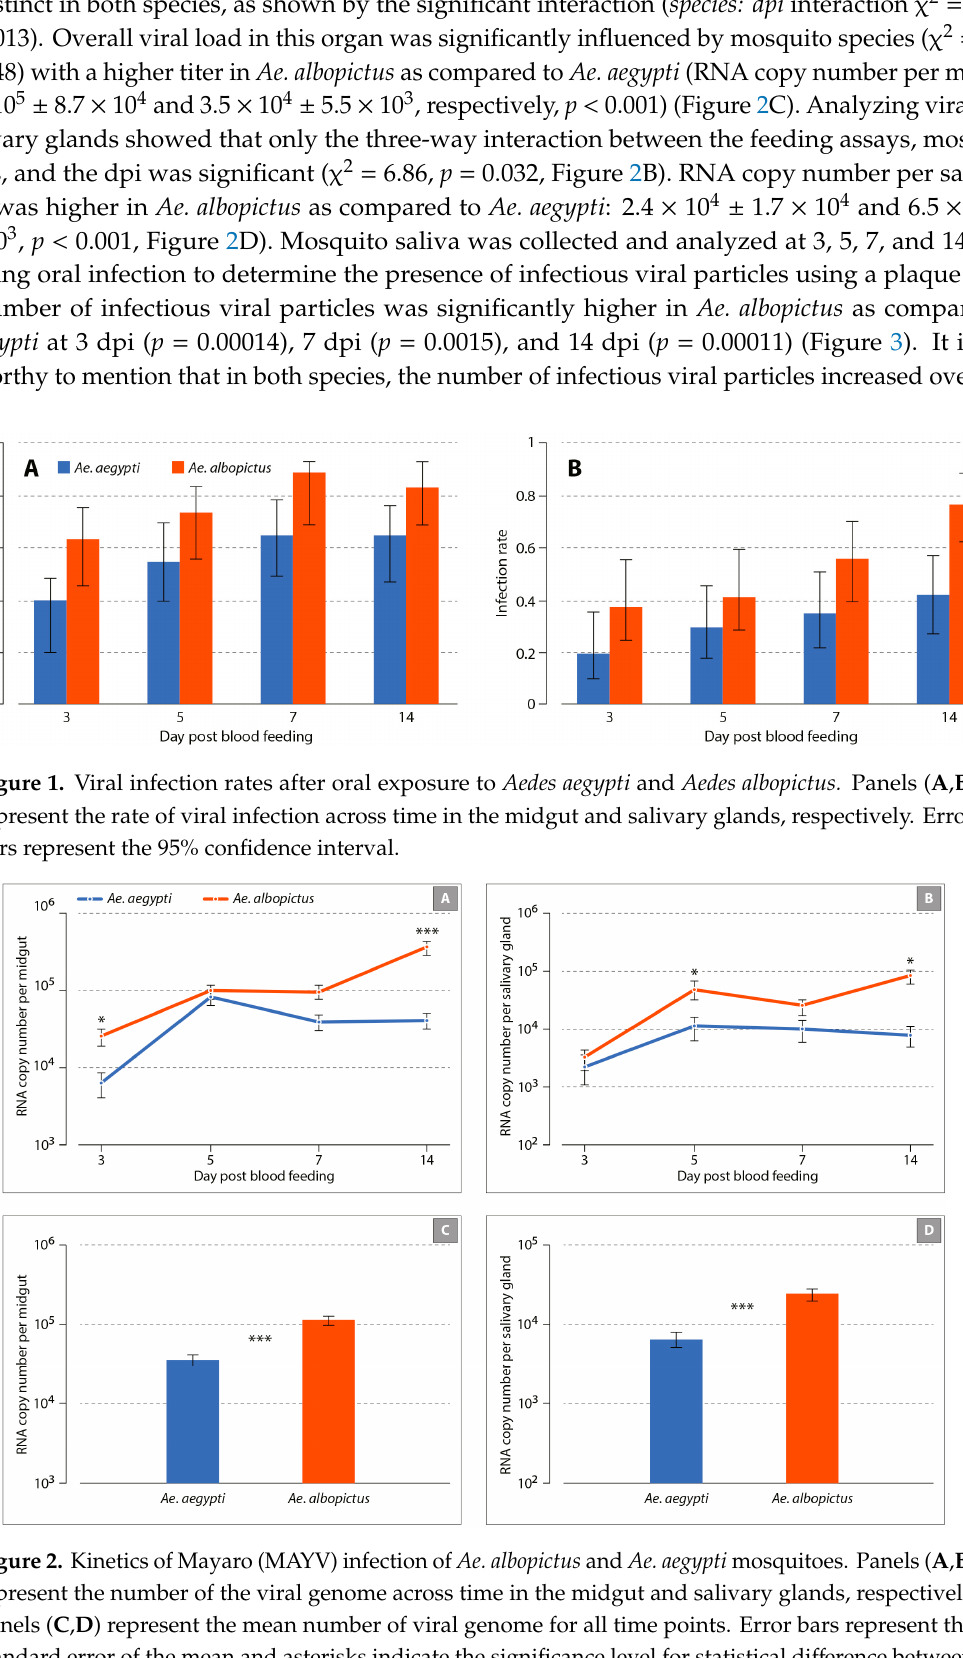
Figure 2. Kinetics of Mayaro (MAYV) infection of Ae. albopictus and Ae. aegypti mosquitoes. Panels ( A , B ) represent the number of the viral genome across time in the midgut and salivary glands, respectively. Panels ( C , D ) represent the mean number of viral genome for all time points. Error bars represent the standard error of the mean and asterisks indicate the significance level for statistical di ff erence between mosquito species: * p < 0.05; *** p < 0.001; non-significant di ff erences were not indicated for